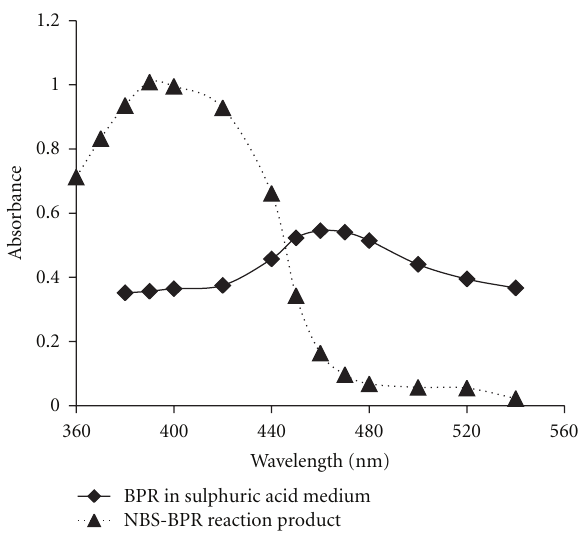
Figure 1: Absorption spectra of BPR in sulphuric acid medium and the reagent blank (bromoderivative of the dye,